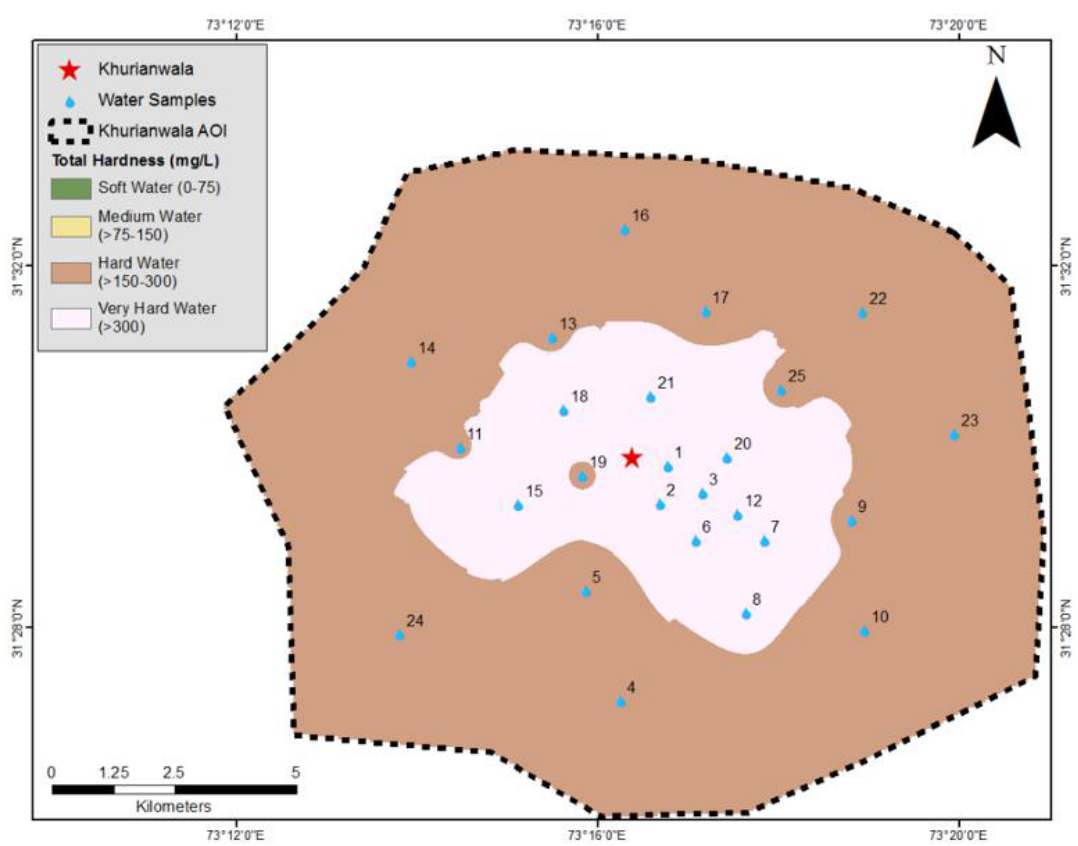
Figure 5. Mapping according to the distribution of total hardness (TH) values based on drinking water quality